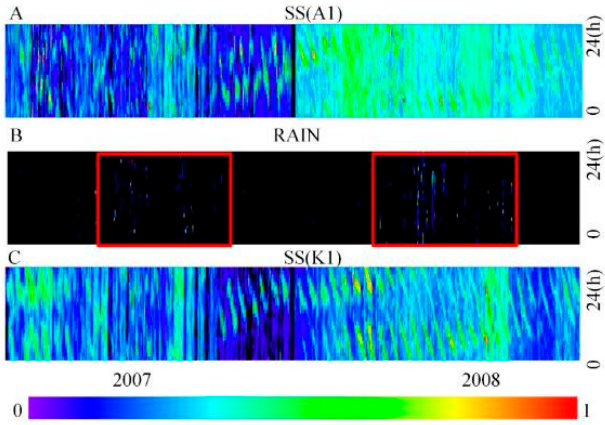
Figure 11. Raster image of suspended sediment (SS) at station A1 ( A ) and K1 ( C ) and rainfall ( B ) in 2007 and 2008. The color denotes the normalized values and black sections represent missing data. Red frames in rainfall image indicate the rainy season.